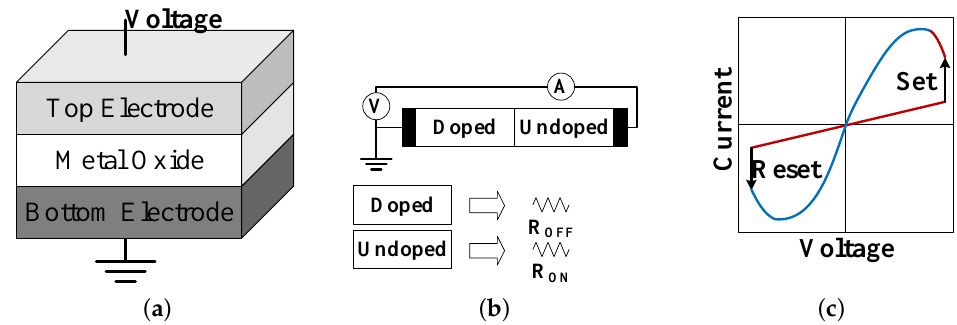
Figure 7. ( a ) Structure of a ReRAM cell; ( b ) memristor switching behavior; and ( c ) I-V curve of bipolar switching (adapted from